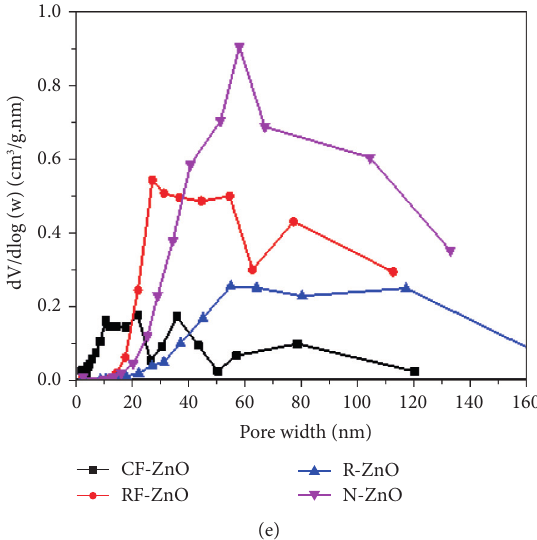
Figure 3: N 2 adsorption/desorption isotherms of (a) CF-ZnO, (b) RF-ZnO, (c) R-ZnO, and (d) N-ZnO, respectively, and (e) pore size distributions.